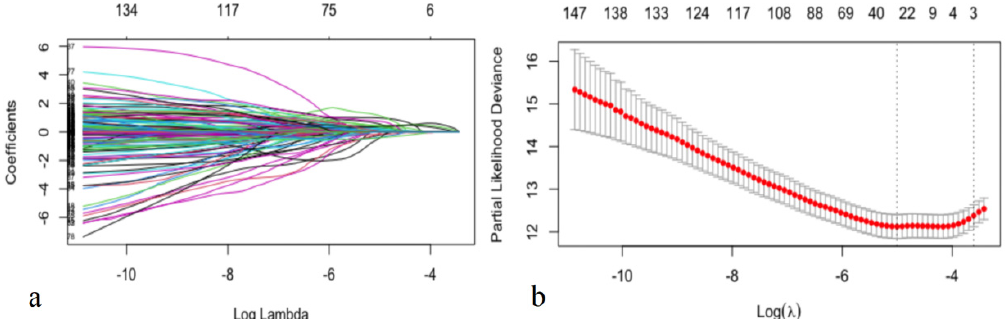
Figure 2. Selecting process for features by Lasso-Cox. Automated feature selection for fifty-seven CCTA variables and nine clinical factors was performed using LASSO-COX, which minimizes the log partial likelihood subject to the sum of the absolute values of the parameters being bounded by a constant, shrinks coefficients, and produces some coefficients that are zero, allowing efficient variable selection ( a ). When the hyperparameters of feature selection were determined (partial likelihood deviance is minimum) ( b ), the algorithm outputted 21 filtered variables with non-zero coefficients (the filtered variables were included in model generation subsequently).